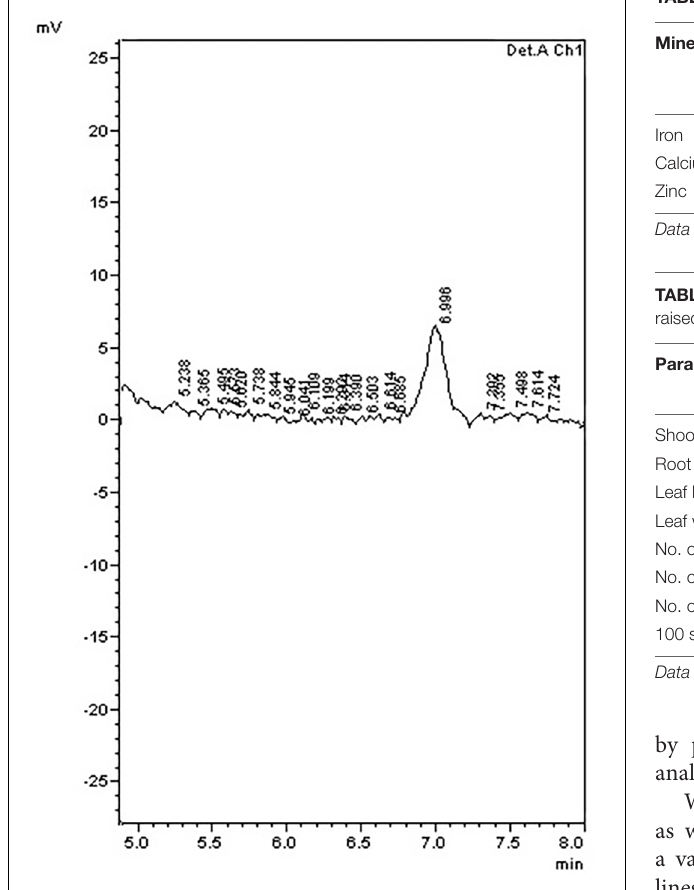
TABLE 2 | In vitro bioavailability assay of T 3 seeds.